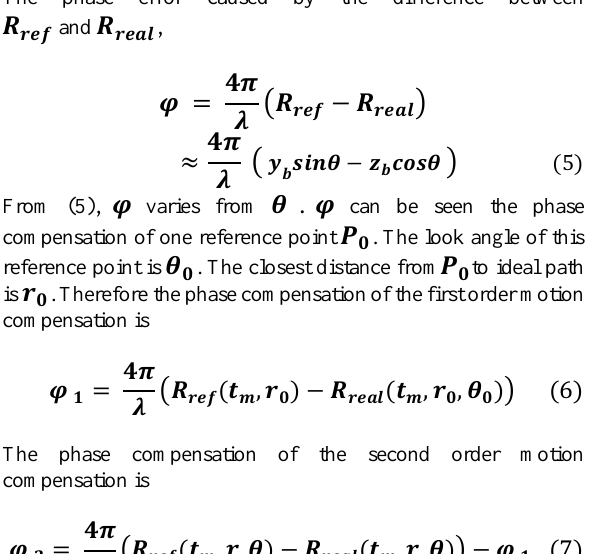
Figure 1. Geometry model of SAR